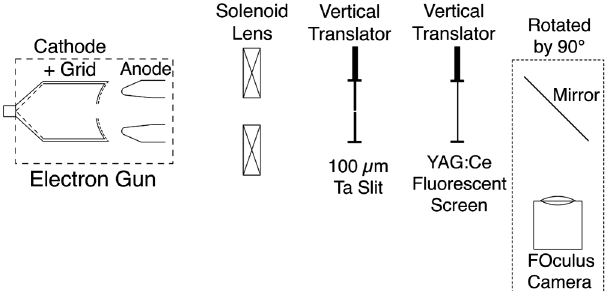
FIG. 10. Schematic of experimental setup for emittance mea- surements (not to scale). The vacuum enclosure is not shown.